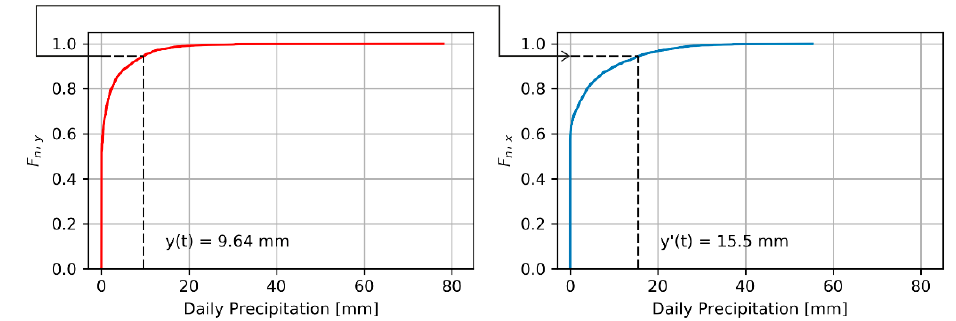
Figure 3. Example of a quantile–quantile-transformation for correcting daily precipitation (mm) at grid point C (12.98° N, 0.00° W) of an ensemble member of SYS4 ( left ) using CHIRPS observations ( right ), y(t) = forecast value and y’(t) = corrected forecast value.